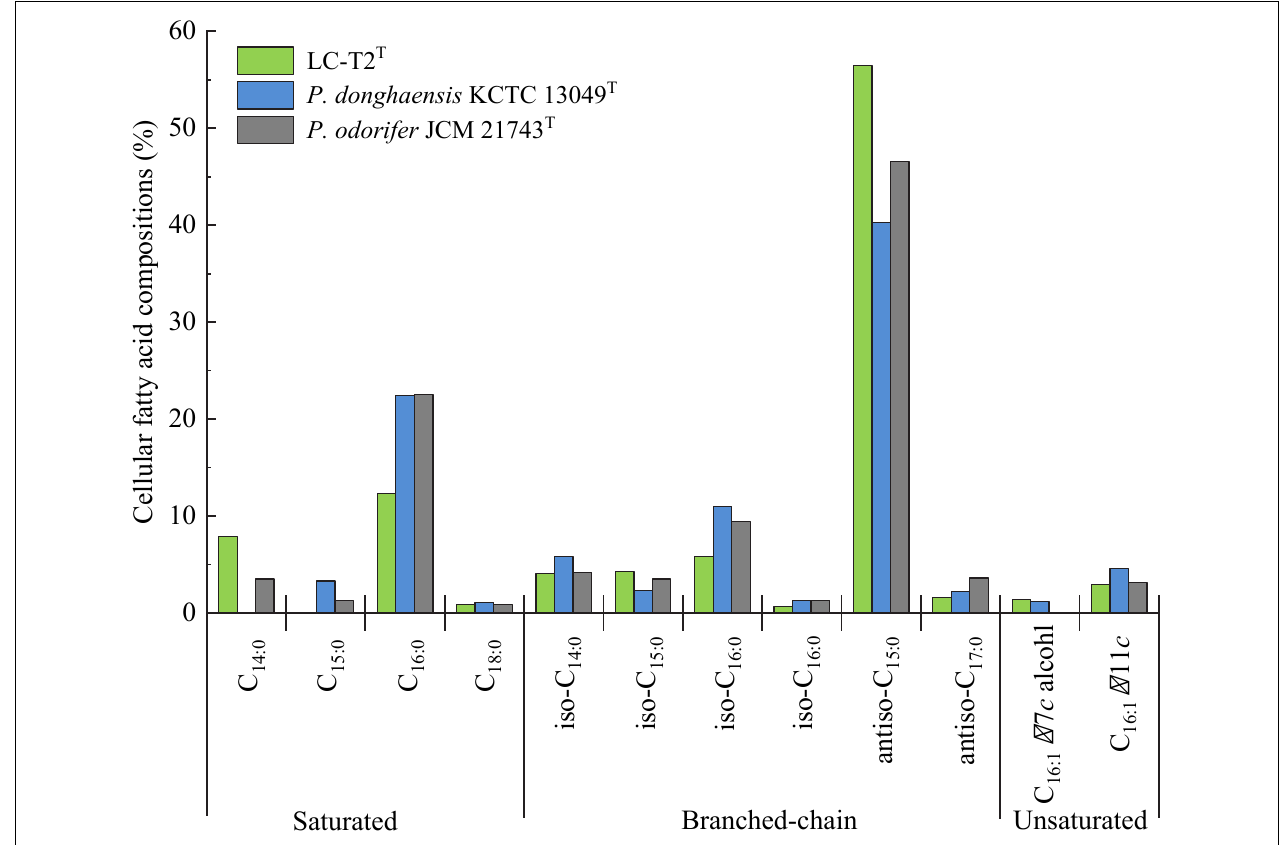
FIGURE 2 | Cellular fatty acid compositions (%) of strain LC-T2 T and the type strains of phylogenetically related species of the genus Paenibacillus.